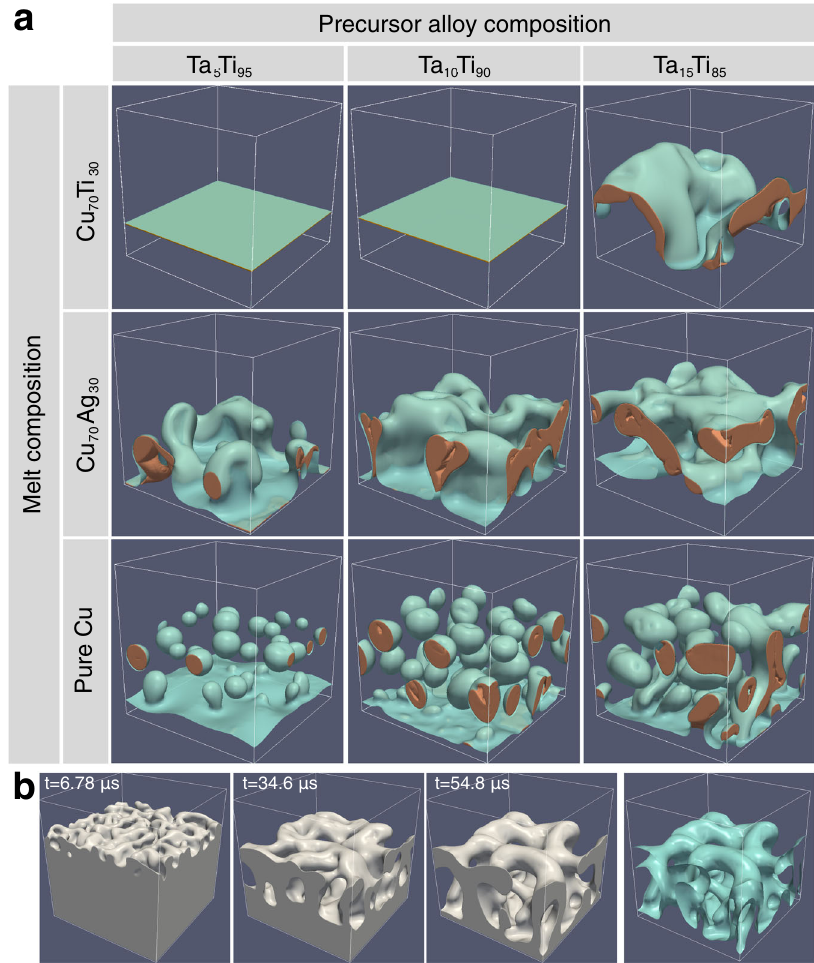
Fig. 1 Effect of melt composition on dealloyed structure topology. a 3D phase- fi eld simulations (128 × 128 × 128 nm 3 ) showing the dramatic effect of solute addition to the liquid melt on fi nal dealloyed morphologies. The top labels denote the compositions (Ta X Ti 1-X ) of the precursor alloy and the vertical labels denote the melt composition of the Cu based dealloying medium. The brown color represents the high Ta concentration regions inside the dealloyed structure and the solid-liquid interface is shown in cyan color. b 3D phase- fi eld simulation (190 × 190 × 190 nm 3 ) of the precursor alloy Ta 15 Ti 85 dealloyed in the Cu 70 Ag 30 melt. The fi rst 3 frames show the solid region of the dealloyed structure at different dealloying depth and the last frame shows only the solid-liquid interface at the largest depth. A movie corresponding to ( b ) is given in the Supplementary Movie